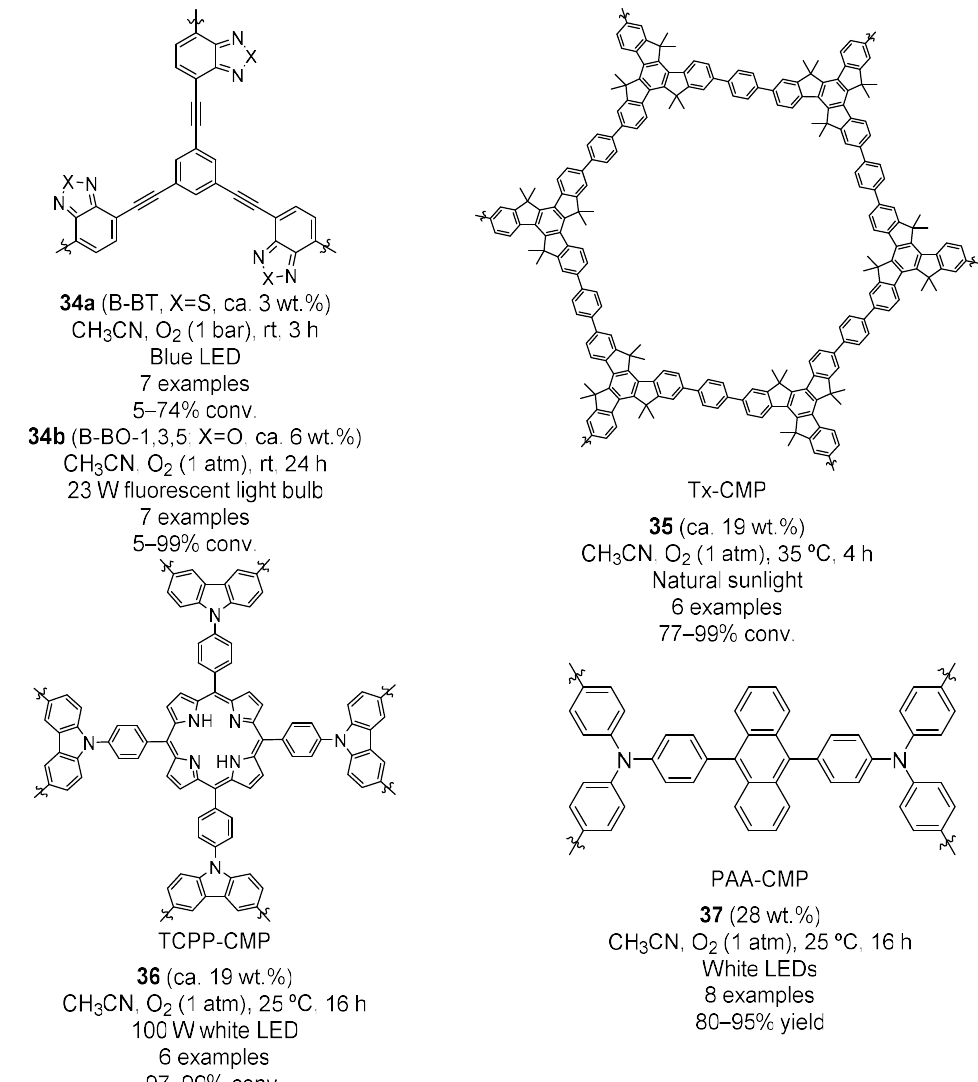
Figure 5. Results obtained in the aerobic photo-oxidative coupling of benzylamines to N -benzylidene benzylamines 2 catalyzed by 34 – 37 . Other CMPs employed as photocatalysts in the same reaction leading to 2 are a truxene-based polymer (Tx-CMP, 35 ) under natural sunlight irradiation [97], a carbazolyl porphyrin-based CMP (TCPP-CMP, 36 ), also employed in the aerobic dehydrogenation of amines to imines shown in Scheme 12 (Ar = Ph, R = i Pr, Bn, CH 2 -(4-MeOC 6 H 4 ), ca. 19 wt.%, CH 3 CN, O 2 (1 atm), 25 ◦ C, 16 h, 100 W white LED, 3 examples, 99% conv.) [98], a triphenylamine-based CMPs functionalized with anthracene moieties (PAA-CMP, 37 ) [99] (Figure 5) and with β -diketone boron difluoride motifs (TPA-B-CMP, 38 ) [100], a boranil- based polymeric material (TDFB-TEB, 39 ) [101] and a pyrene-based polymeric promoter (CMP-A, 40 ) [102] (Figure 6). In all cases, excellent results were obtained. It should be noted that all the catalysts could be recovered by centrifugation, washing and drying ( 35 , 38 and 39 ), by simple centrifugation ( 36 and 37 ) or by filtration ( 40 ), maintaining their activity for five/six cycles without any noticeable change in